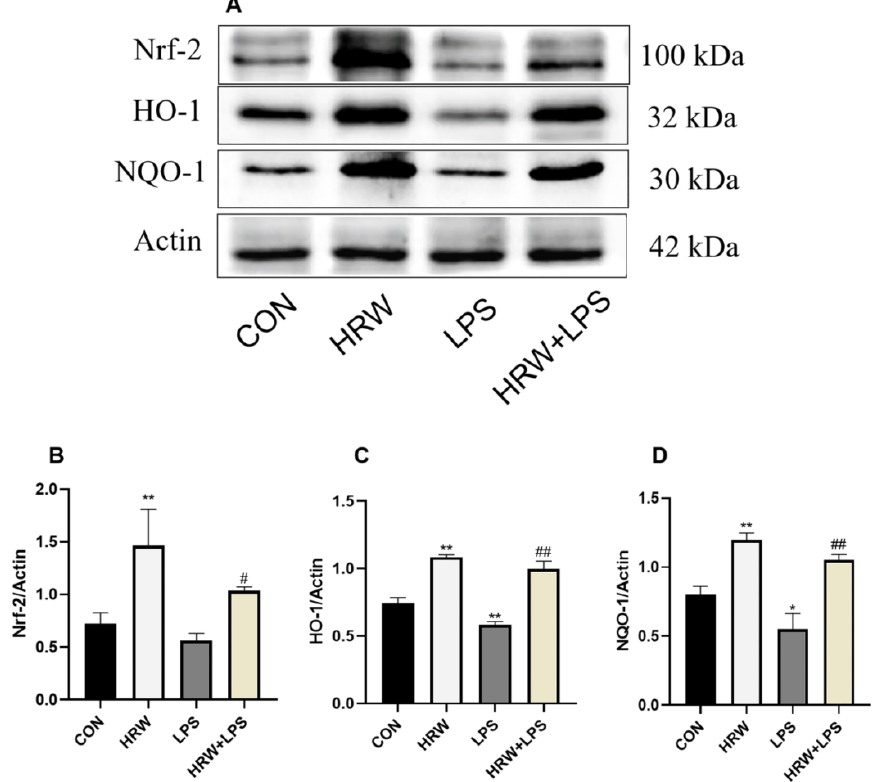
Figure 6. Effects of HRW on the Nrf-2 signaling pathway in rats with chronic gut inflammation. ( A ) Blot bands of protein expression related to the Nrf-2 signaling pathway. Protein levels of the Nrf-2 signaling pathway were detected by Western blotting: ( B ) Nrf-2; ( C ) HO-1; ( D ) NQO-1. * p < 0.05, ** p < 0.01 compared to the CON group; # p < 0.05, ## p < 0.01 compared to the LPS group. *, # p < 0.05; **, ## p < 0.01. Please view the original image in the File S1.